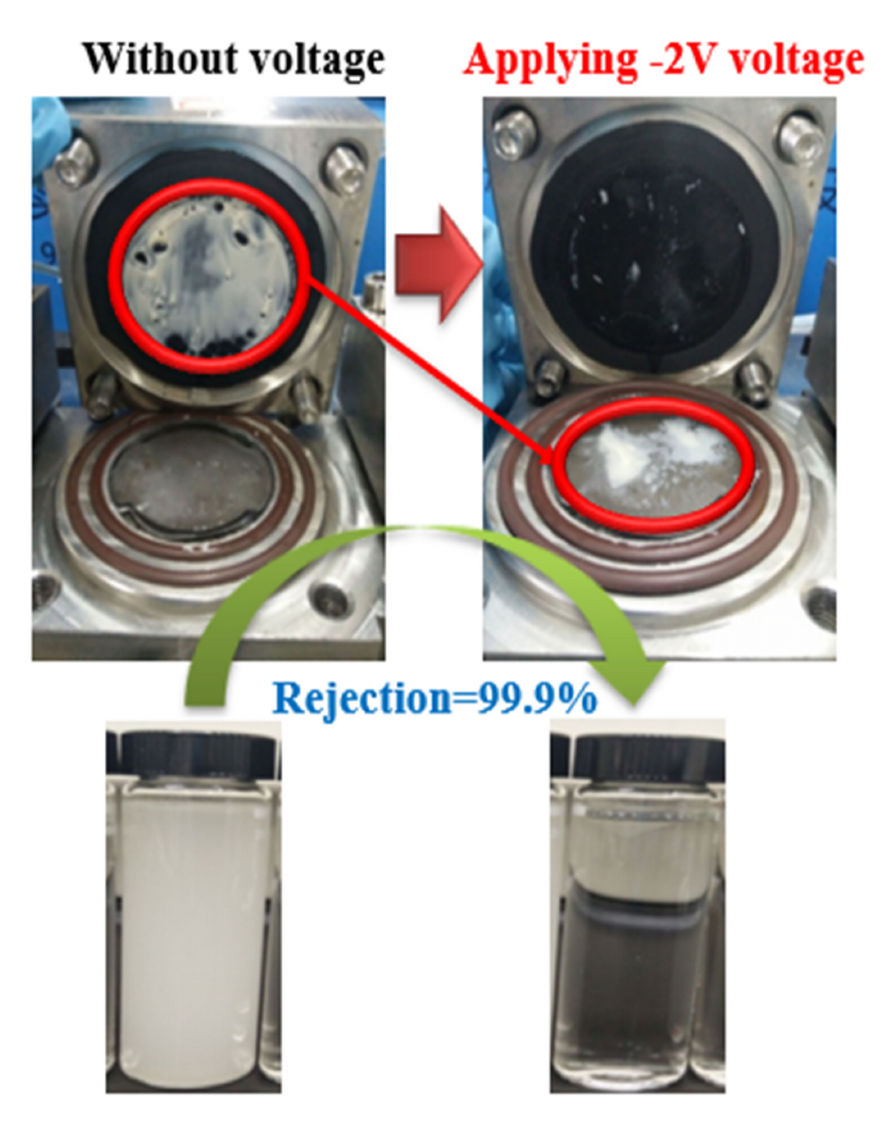
Figure 10. Antifouling performance of MWCNTs-25 membrane without and with